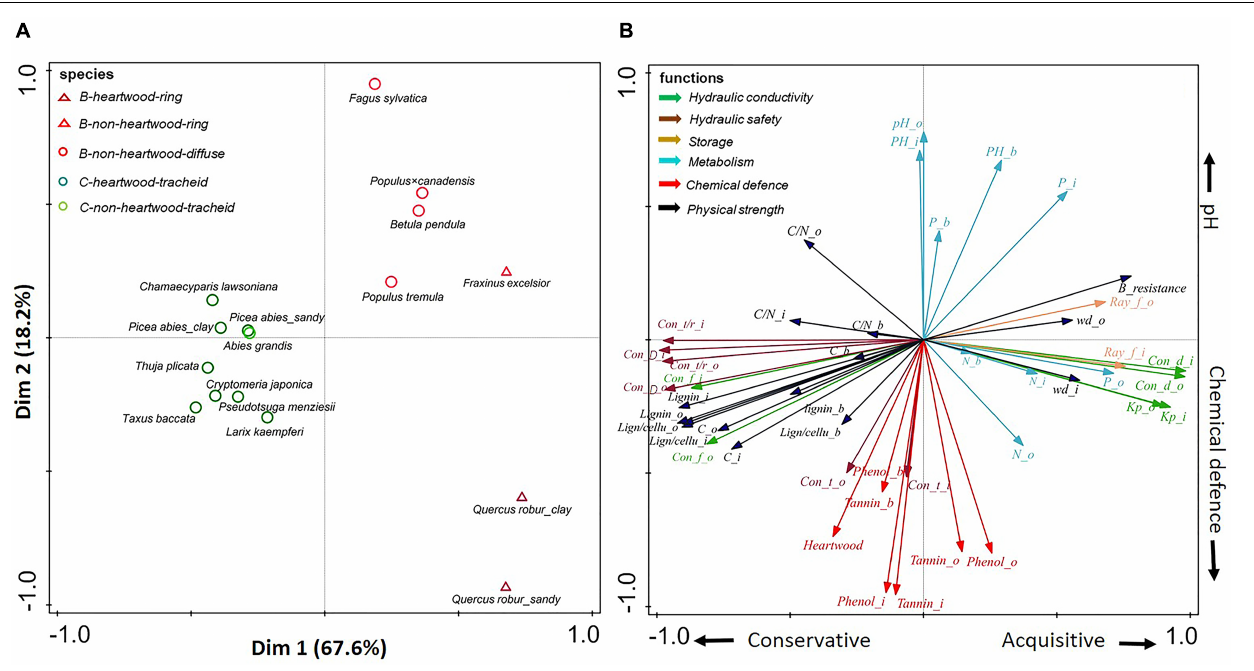
FIGURE 3 | (A,B) Principal-component analysis of 20 stem traits of three compartments (inner wood, outer wood, and bark) of all tree species. Dark green circles show gymnosperms with heartwood; light green circles show gymnosperms without heartwood; dark red triangles show ring-porous angiosperm species with heartwood; light red triangles show ring-porous angiosperm species without heartwood; light red circles show diffuse-porous angiosperm species without heartwood. The traits (indicated with arrows) are grouped according to six functions: hydraulic conductivity (in green), hydraulic safety (in dark brown), storage (in light brown), metabolism (in blue), chemical defense (in red), and physical strength (in black). For trait abbreviations see Supplementary Table 2